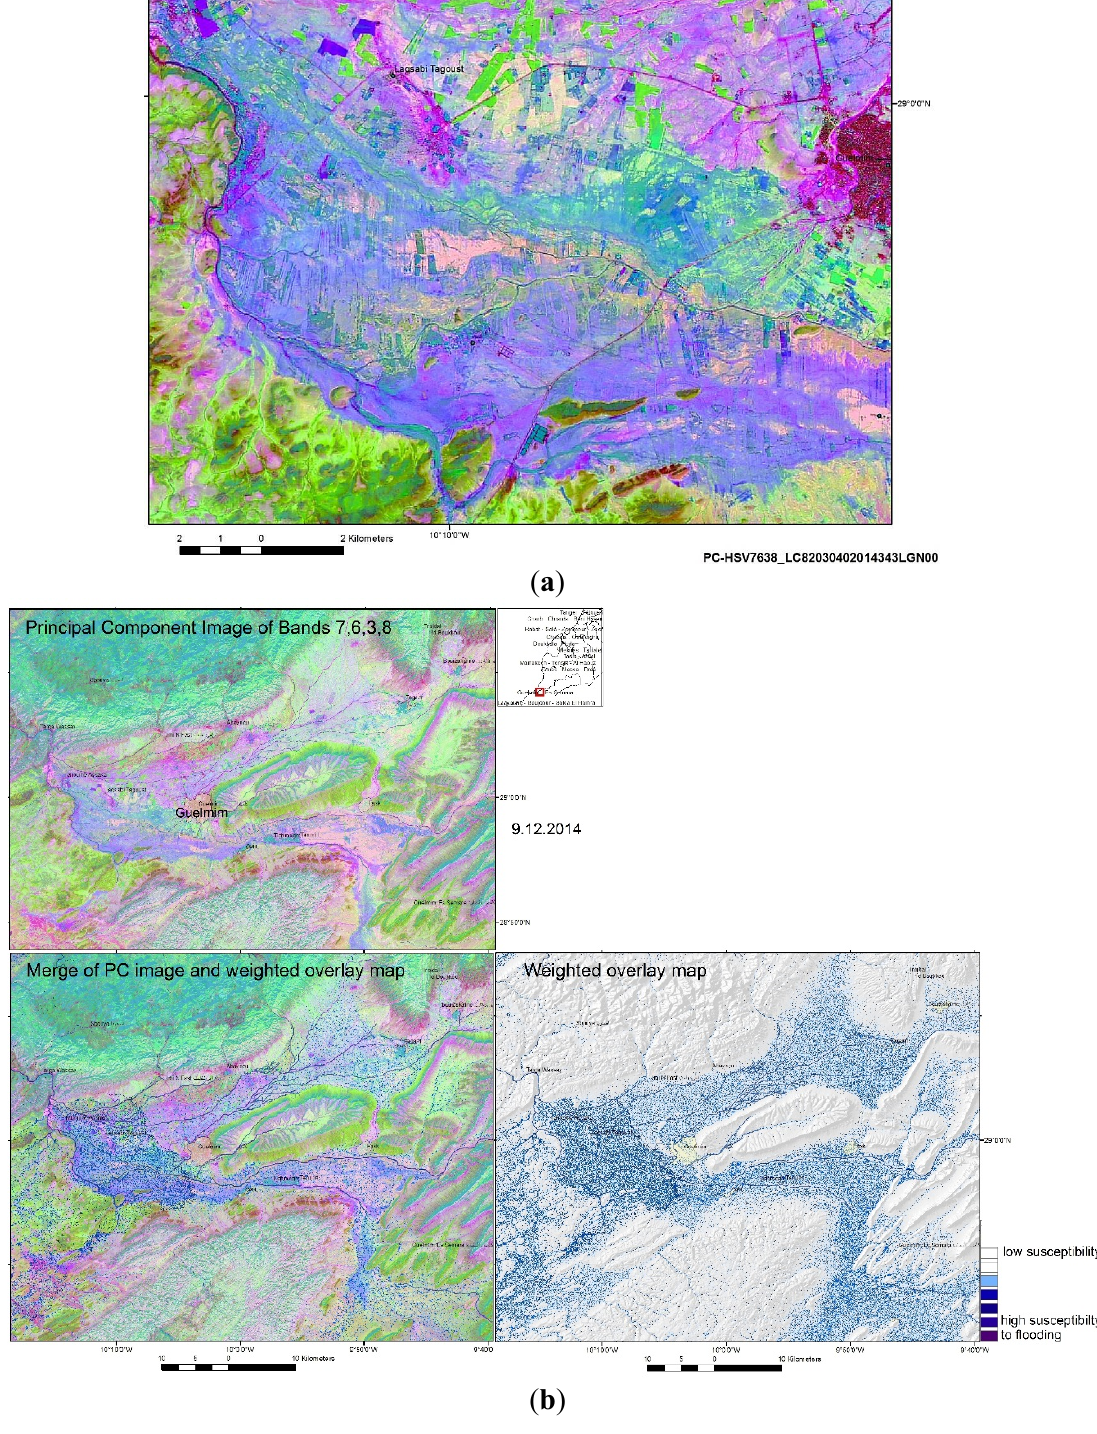
Figure 12. ( a ) PC Landsat 8 image showing recent sedimentary deposits (blue-violet) after the November 2014 flash floods; ( b ) Comparison of the weighted overlay results with the Landsat 8 principal component image. The areas with the highest susceptibility to flooding due to their morphometric properties were flooded during the November 2014 flash